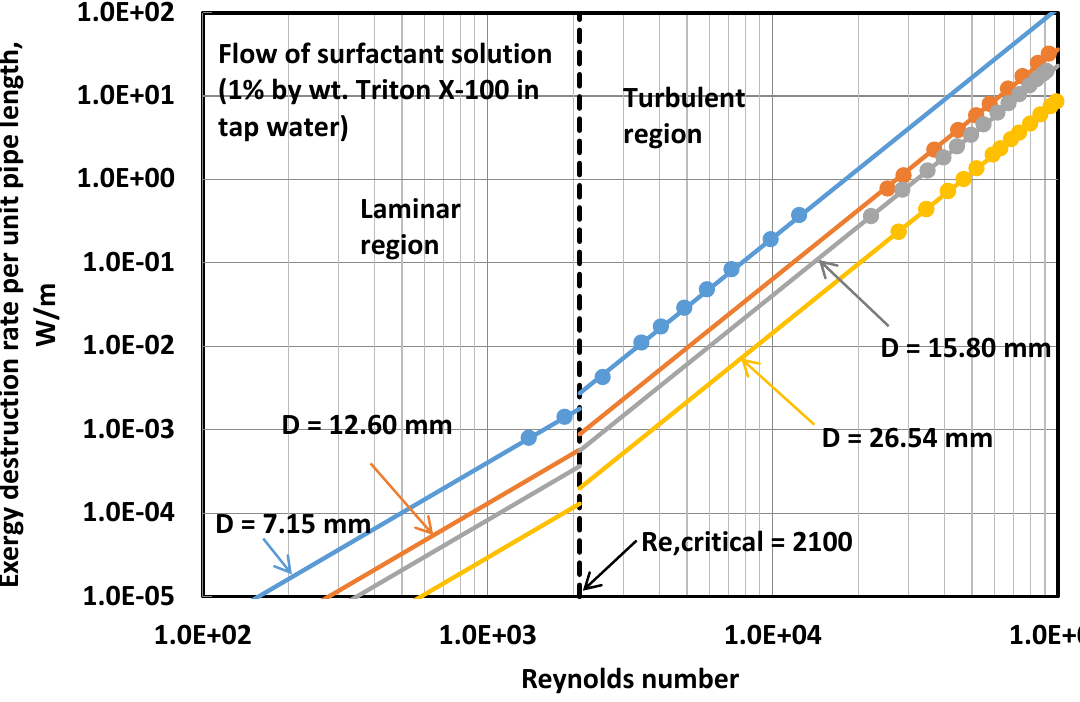
   versus Re plots for the surfactant solution (1% by wt. Triton X-100 aqueous D solution) in different diameter